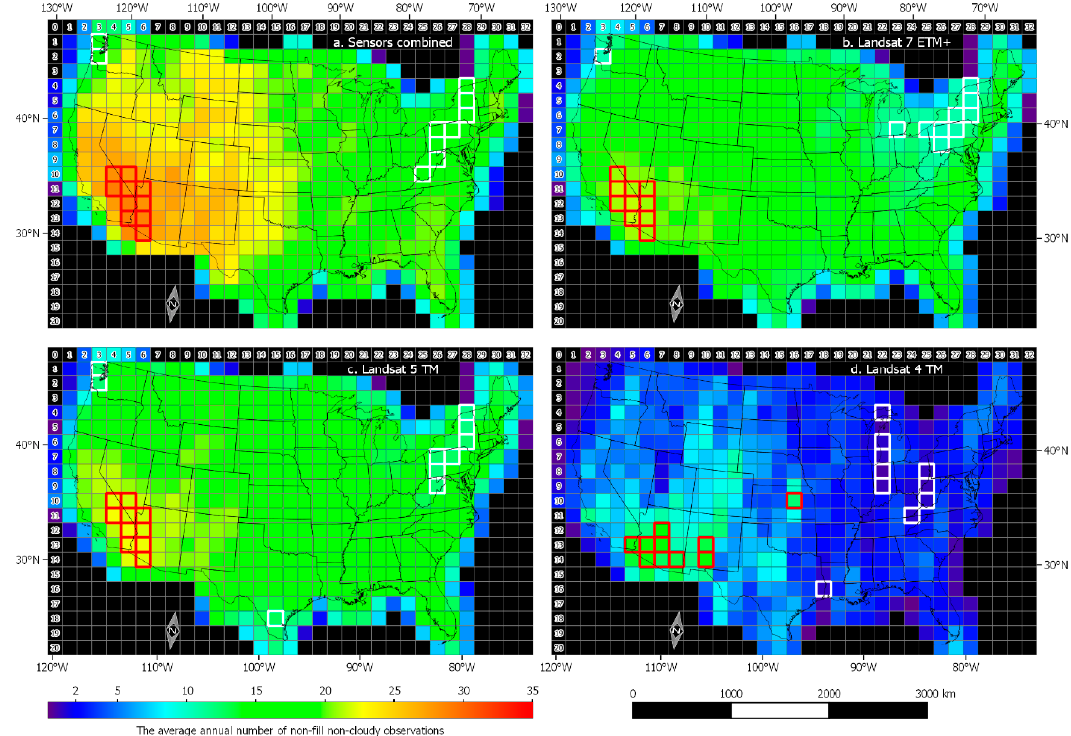
Figure 9. The average annual number ( µ sensor , Equation (3)) of non-fill non-cloudy observations across each CONUS ARD tile over the 36 year study period for ( a ) Landsat 4 TM, 5 TM and 7 ETM+ combined, ( b ) Landsat 7 ETM+, ( c ) Landsat 5 TM, ( d ) Landsat 4 TM. The ten most (red outlined) and the ten least